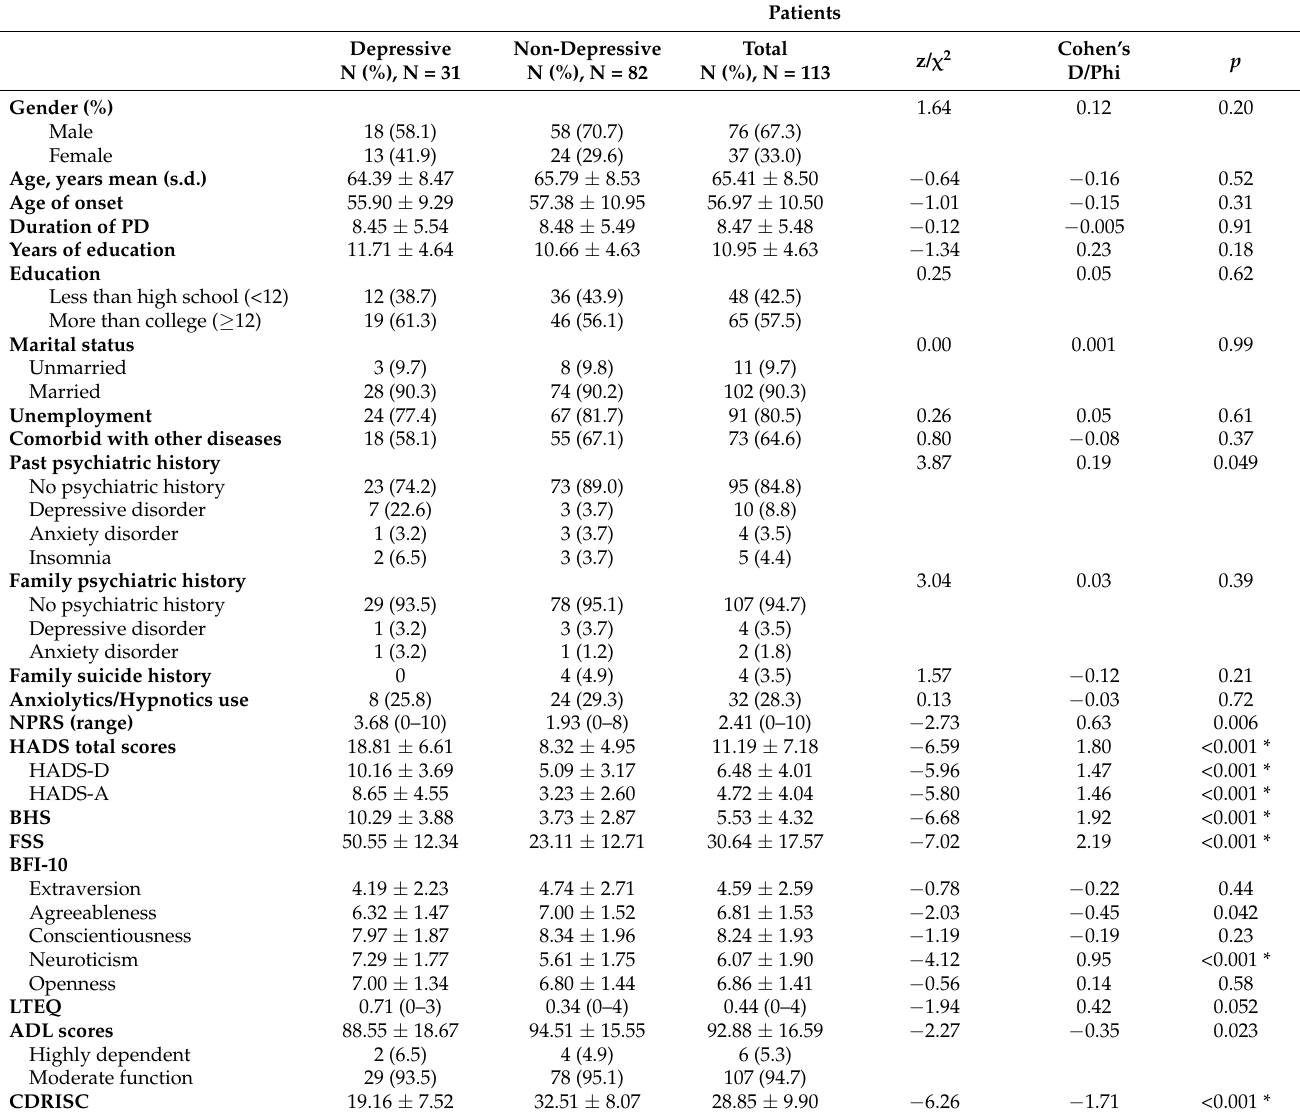
Table 1. Demographic and clinical characteristics of the patients with Parkinson’s disease at 12-month follow-up (N =